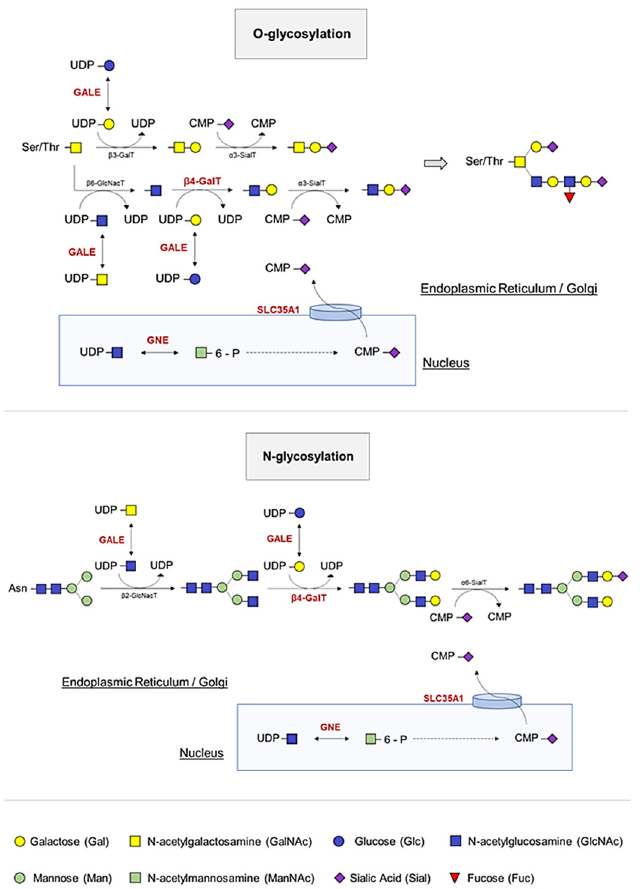
Figure 3. O- and N-linked glycosylation and sialylation of platelets. The GALE protein allows the interconversion of four essential molecules in the glycosylation process by serving as substrates for other enzymes, which incorporate the carbohydrates of interest and release UDP. During glycosyla- tion, branching of carbohydrates occurs. B4GALT1 transfers galactoses from UDP-Gal to the terminal GlcNAc. A final cleavage of sialic acid prevents platelet clearance. GNE and SLC35A1 participate in the pathway that allows incorporation of this sialic acid into platelet